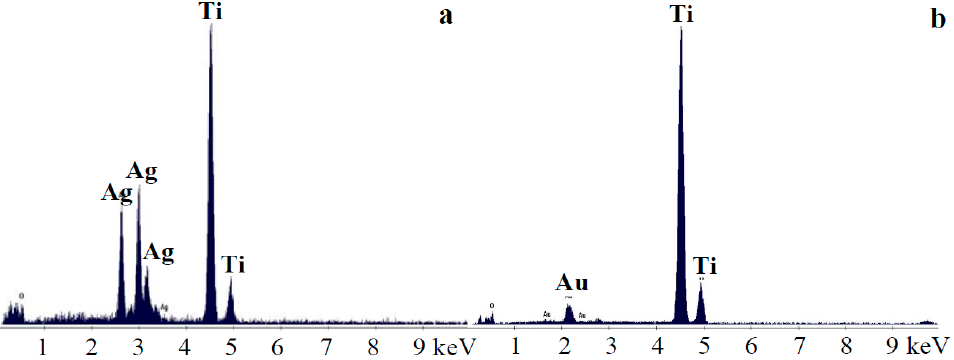
Figure 2. EDS spectra of the Ag–TiO 2 film ( a ) and Au–TiO 2 film ( b ).